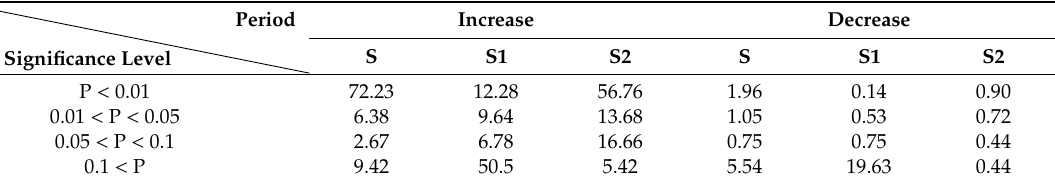
Table 4. The proportion of pixels that showed increases and decreases in vegetation growth for S, S1, and S2, for each significance level according to the F-test (Unit: %).